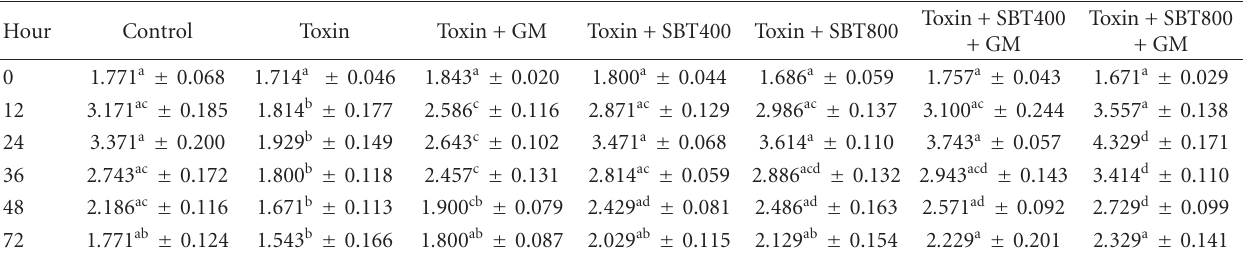
Table 3: E ff ect of dietary supplementation of seabuckthorn berries (SBT) and glucomannan (GM, mycotoxin binder) on skin thickness (mm) in delayed-type hypersensitivity reaction in birds fed with T-2 toxin.